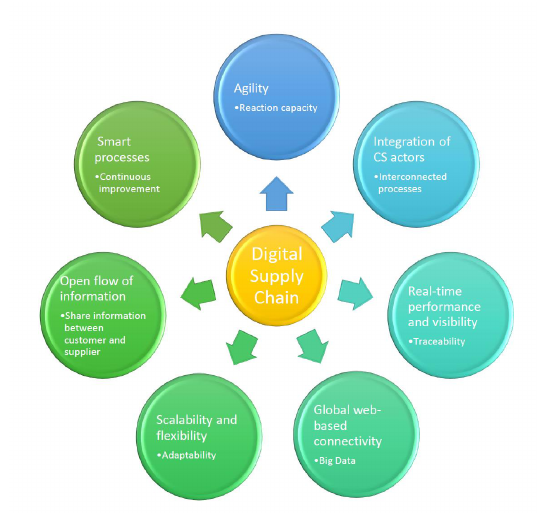
Figure 6. Drivers of Digital Supply Chain.